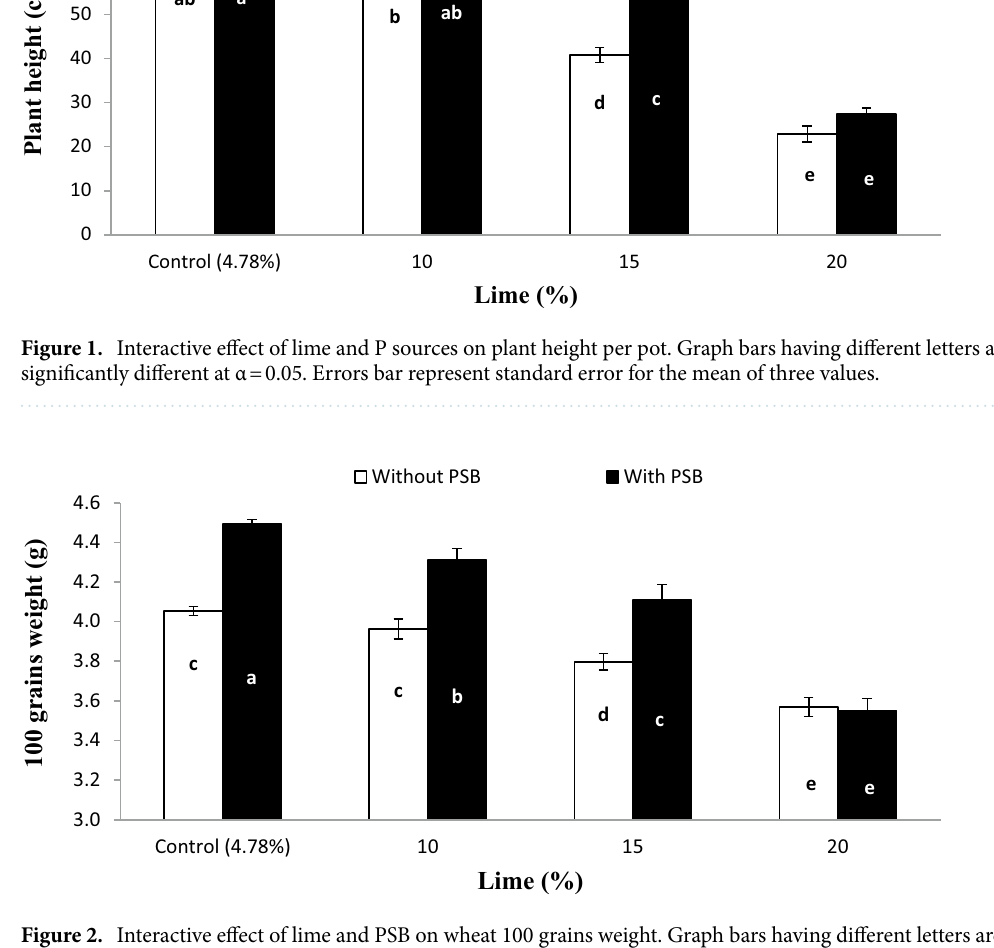
Figure 2. Interactive effect of lime and PSB on wheat 100 grains weight. Graph bars having different letters are significantly different at α = 0.05. Errors bar represent standard error for the mean of three